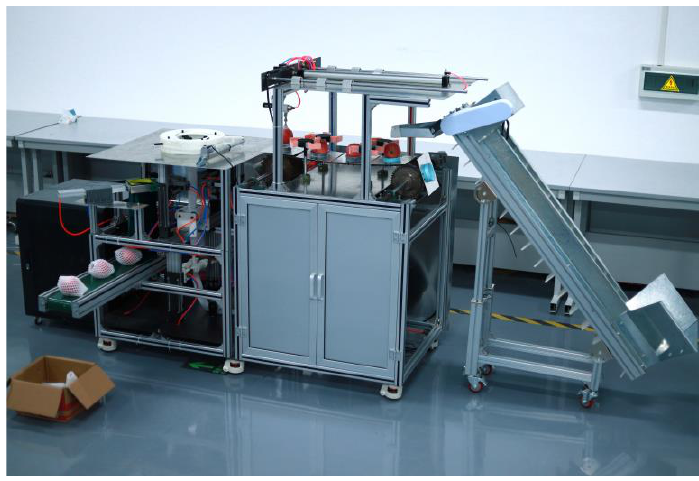
Figure 23. Prototype apple foam net sleeve packaging machine.